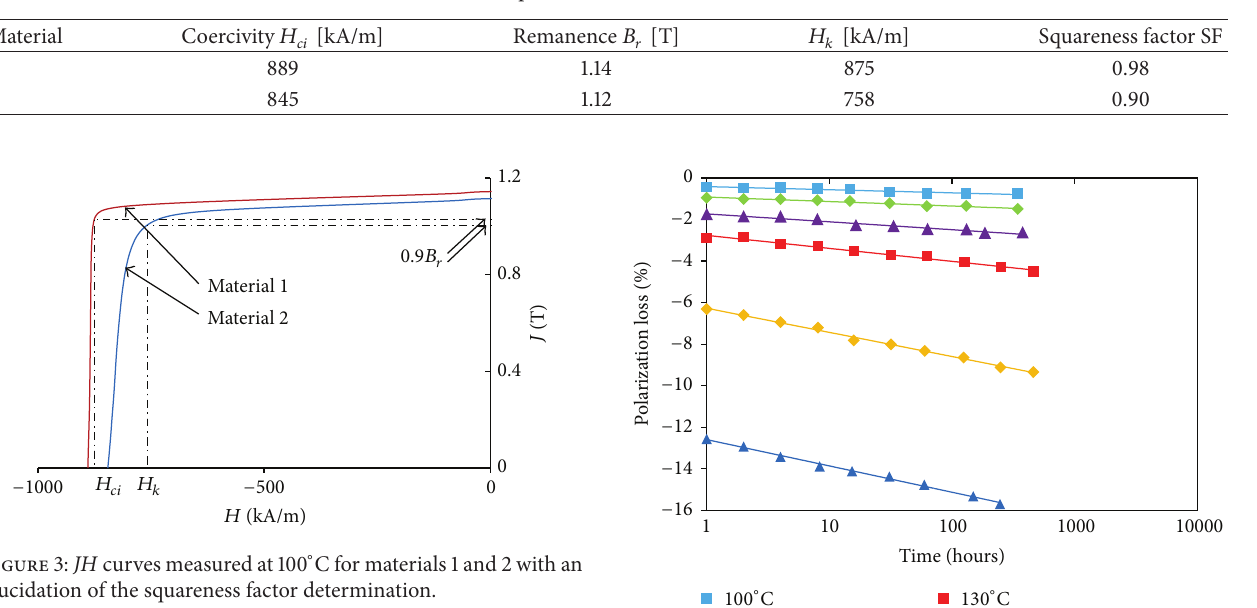
Table 2: Properties of the materials at 100 ∘ C.